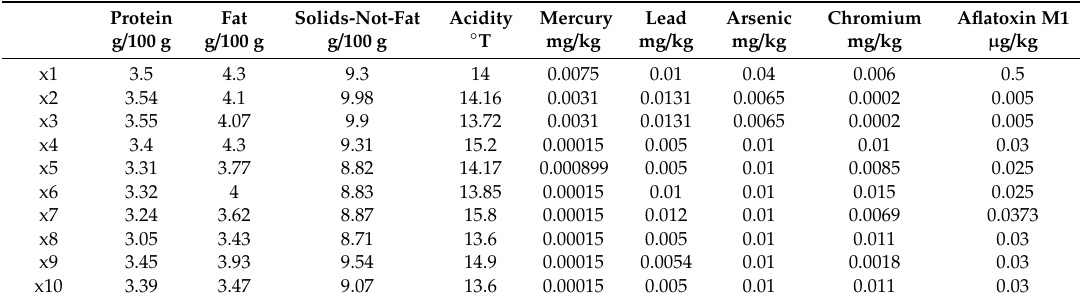
Table 2. The data after preprocessing of the infant milk